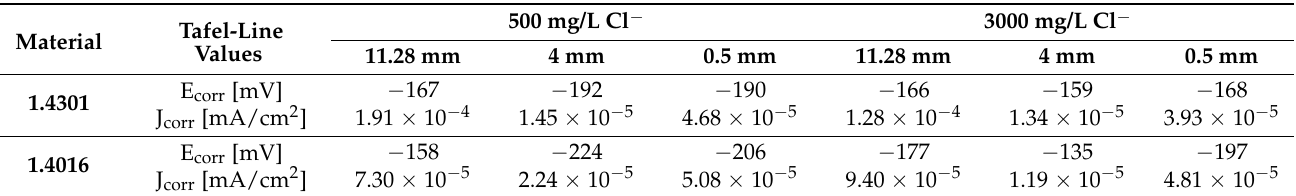
Figure 4. Bar chart of 1.4301 and 1.4016 representing the mean pitting and corrosion potential for different diameters of the test area based on three repeated tests for each condition. A = 11.28 mm; B = 4 mm, C = 0.5 mm and two different chloride ion concentrations of 500 mg/L and 3000 mg/L. Table 2. Mean values of the corrosion potential (E corr ) and the corresponding current density (J corr ) of the 1.4301 and 1.4016 for different diameters of the test area based on three repeated tests for each condition. A = 11.28 mm; B = 4 mm, C = 0.5 mm and two different chloride ion concentrations of 500 mg/L and 3000